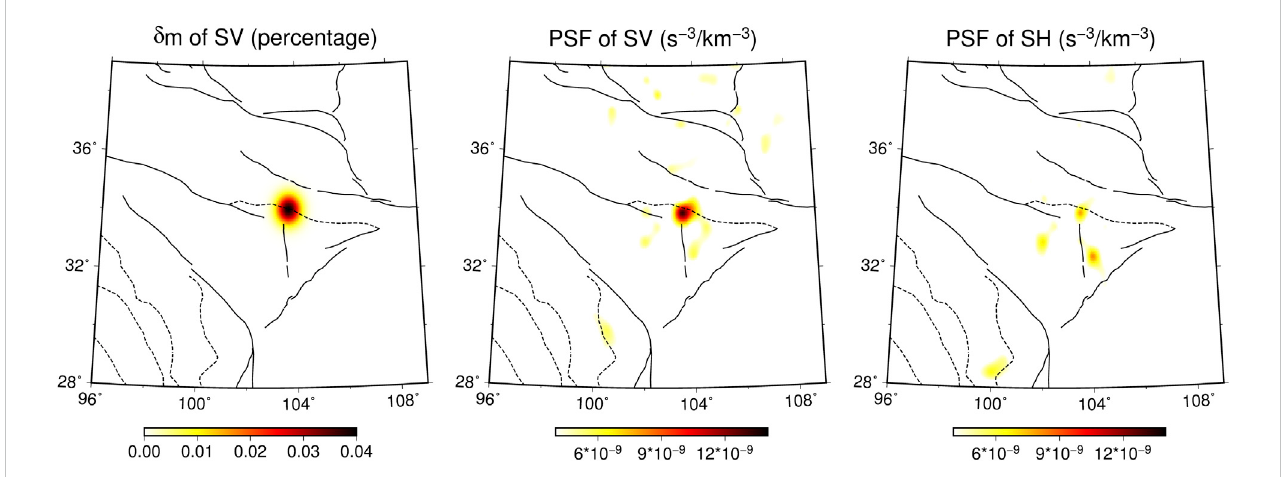
FIGURE 2 Point-spread function resolution test at the depth of 200 km beneath the eastern Tibetan Plateau. (A) The input Gaussian perturbation for V SV . (B) The PSF output for V SV . (C) The PSF output for V SH